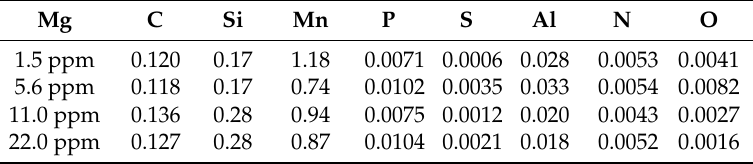
Table 1. Chemical composition of SS400 steel with Mg of 1.5–22 ppm (Unit: wt%). Mg C Si Mn P